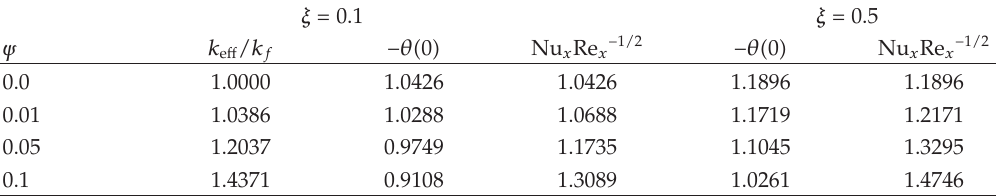
Table 4: Water-Al 2 O 3 nanofluid (cid:5) Pr (cid:8) 6.2, m (cid:8) 1, p (cid:8) 1, ∧ (cid:8) 0 . 1 (cid:6)